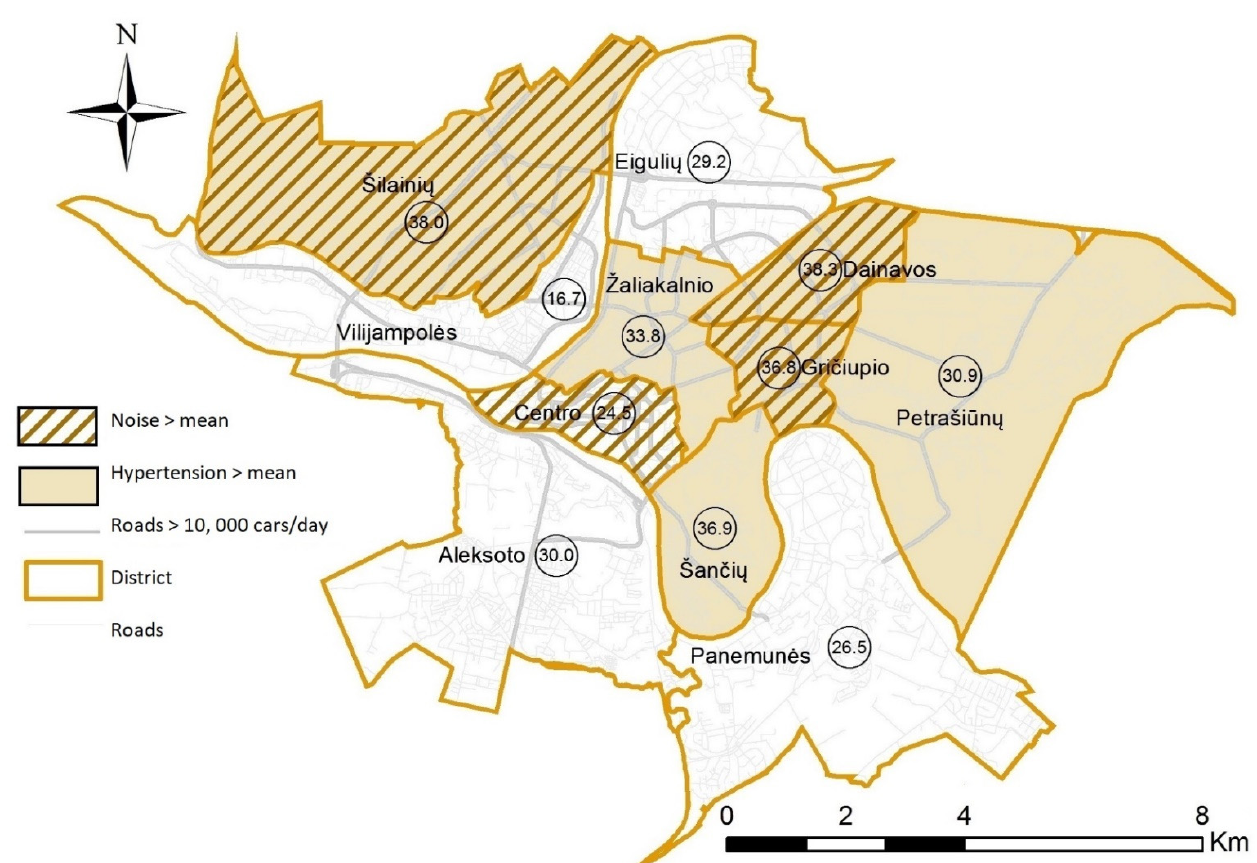
Figure 1. Spatial distribution of exposure to noise (by mean) and the unadjusted prevalence of hypertension (%) at the Kaunas district level among 45–64-year-old participants.